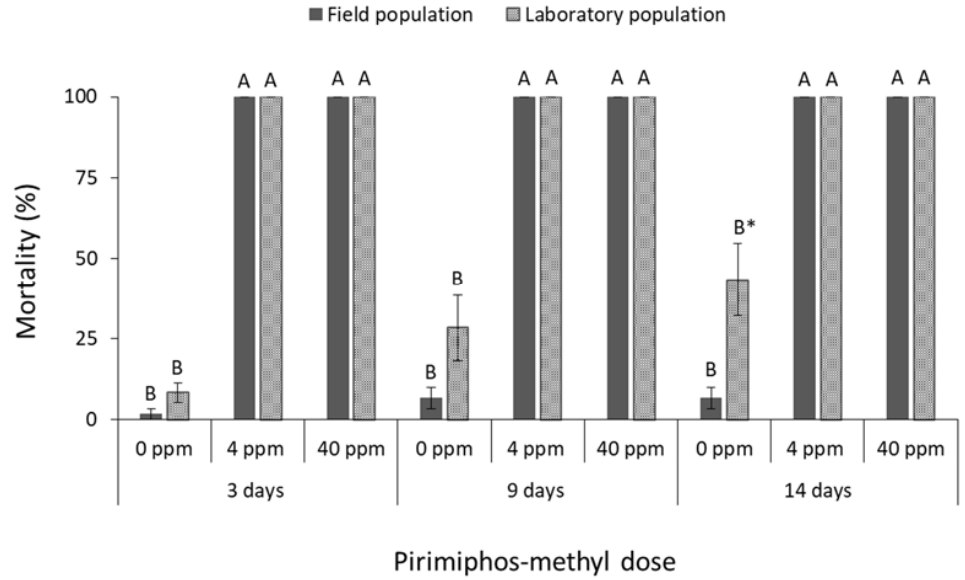
Figure 9. Mean (% ±SE) adult mortality of field and laboratory populations of C. ferrugineus after 3, 9 and 14 days of exposure to different concentrations of pirimiphos ‐ methyl (within each exposure interval and population, means followed by the same letter are not significantly different; where no letters are present, no significant differences were noted; HSD test a 0.05; within each exposure interval and dose, means with asterisk (*) indicate significant differences between the populations, according to Students’ t –test at p < 0.05).